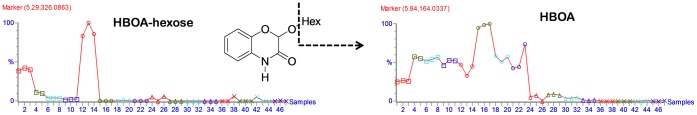
Occurrence of the benzoxazinoid HBOA-hexose and its deglucosylated form.Three replicates from each sample type are shown; the symbols are: squares, extractable fraction (E); circles, extractable fraction in lower concentration (EL); triangles, unextractable fraction (UE); and crosses, faecal background (FB) samples. The different time points are represented with different colors: red, 0 h; green, 4 h; turquoise, 12 h; and blue, 48 h.